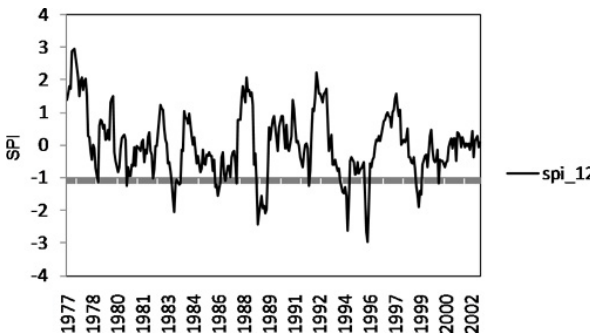
Fig. 5. SPI and drought periods for Tarragona in the Ebro river